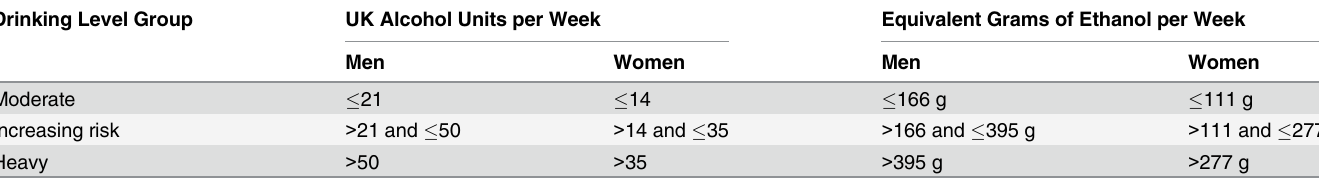
Table 1. Weekly consumption thresholds for drinking level